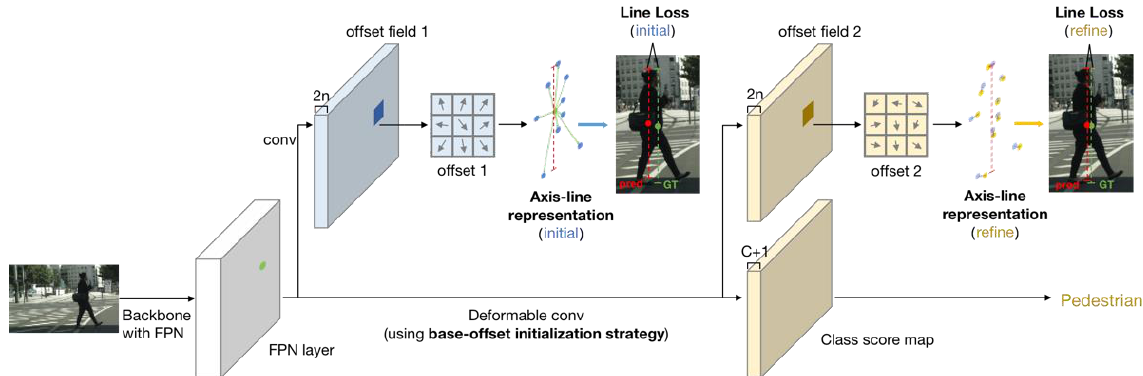
Figure 1. Overview of the proposed RPDet+ALR framework. Different from the original RPDet, we use the axis-line representation in initial/refine stages and the learning is supervised by line loss during training. Besides, the deformable convolution is strengthened by our base-offset initialization strategy. For clear illustration, we only draw the pipeline of one scale of FPN feature maps. All of our modifications are in bold.